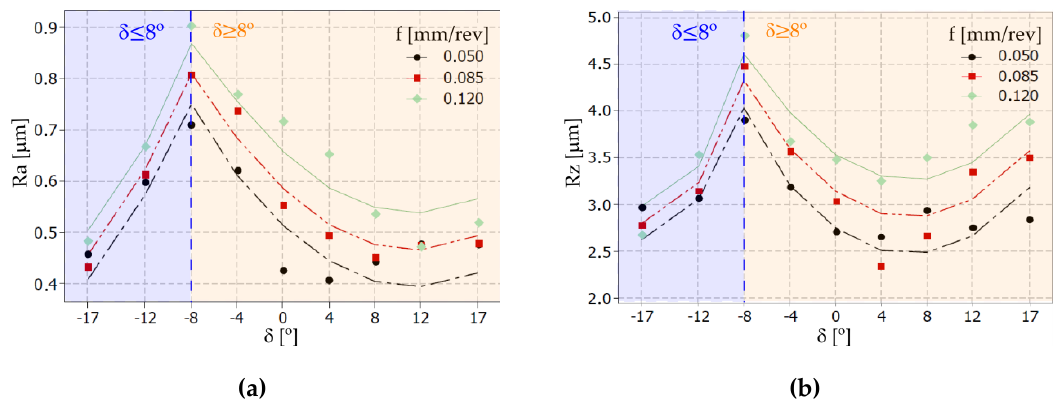
Figure 9. Graphs representing the relation between the tilted angle δ of the machined surface and the surface roughness parameters: ( a ) Ra and ( b ) Rz ; for different feed rate parameters values.